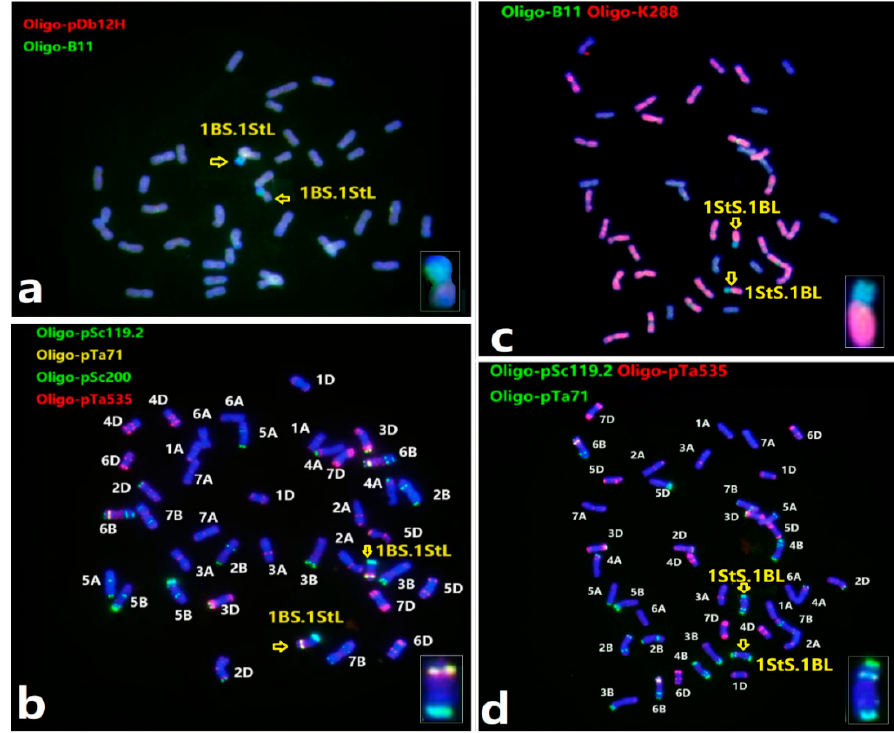
Figure 3. Sequential ND-FISH patterns showing wheat- Th. intermedium homozygous 1St translocation lines. ( a , b ) 1BS.1StL and ( c , d ) 1BL.1StS. The probes for FISH were: ( a ) Oligo-B11 (green) with Oligo-pDb12H (red); ( b ) Oligo-pSc119.2 (green) with Oligo-pTa535 (red); ( c ) Oligo-k288 (red) with Oligo-D (green); and ( d ) Oligo-pSc119.2 (green) with Oligo-pTa535 (red). The arrows indicated the translocation chromosomes.